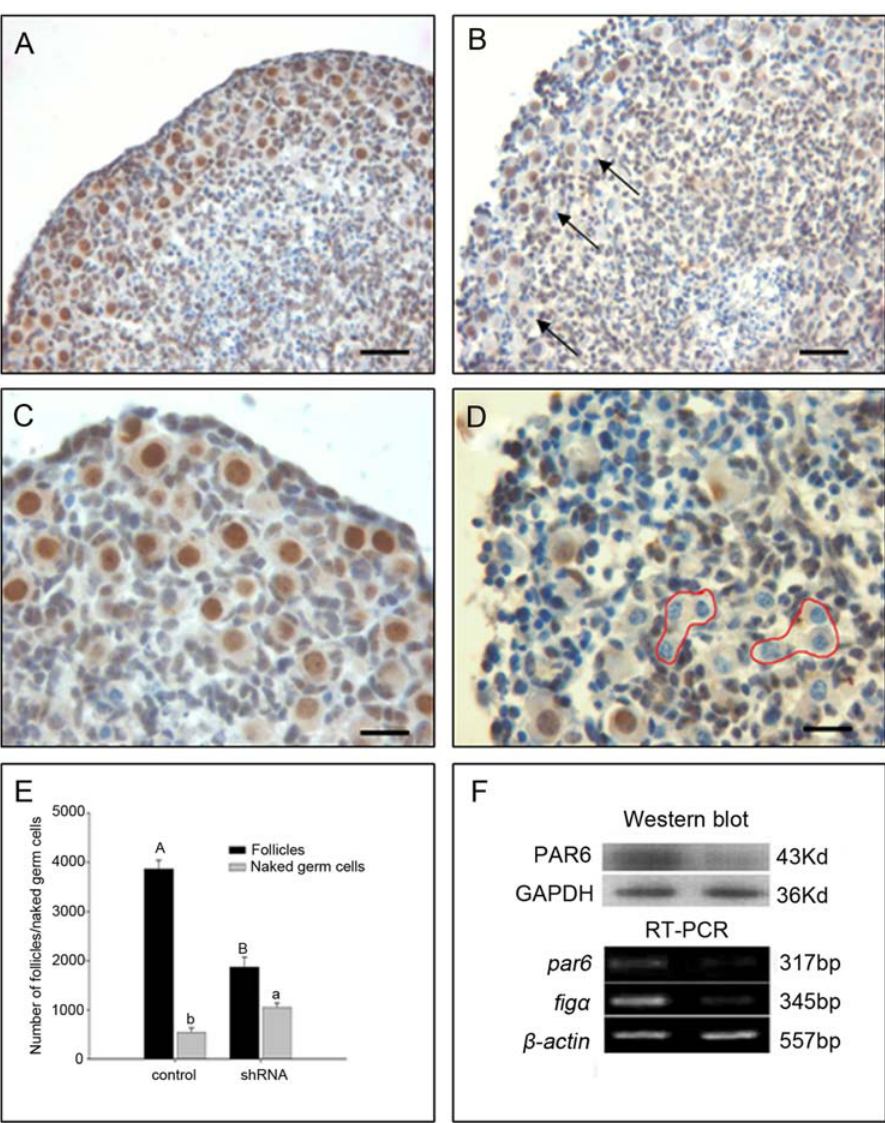
Figure 4. Loss of PAR6 disrupted ovarian histogenesis and reduced follicular formation. 15.5 dpc ovaries were treated with control shRNA plasmid or shRNA for 12 hours, cultured for 6.5 days, then the shape of ovaries and the localization of PAR6 (A and C, control; B and D, shRNA ), the number of follicles and naked germ cells (E), the expression of mRNA and protein (F) were examined. Arrows noted the naked germ cells and red rounds noted the cysts with PAR6 negative germ cells. Each data came from five ovaries, different superscripts denote differences (P , 0.05) respectively. RT-PCR and Western blot were repeated at least three times with similar results. A and B, Bar=40 m m; C and D, Bar=20 m m.